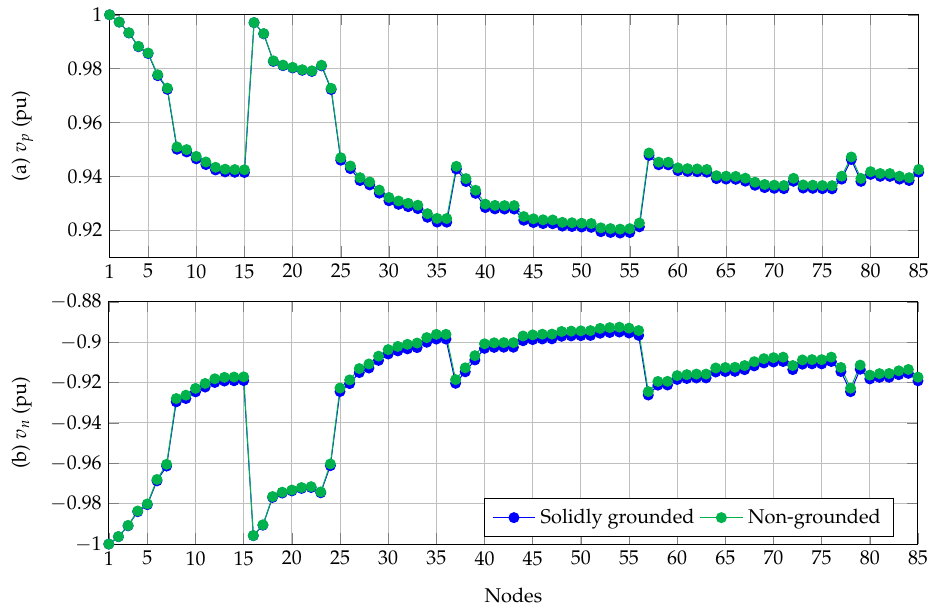
Figure 6. Voltage behavior for the 85-bus grid considering a solidly grounded or non-grounded neutral